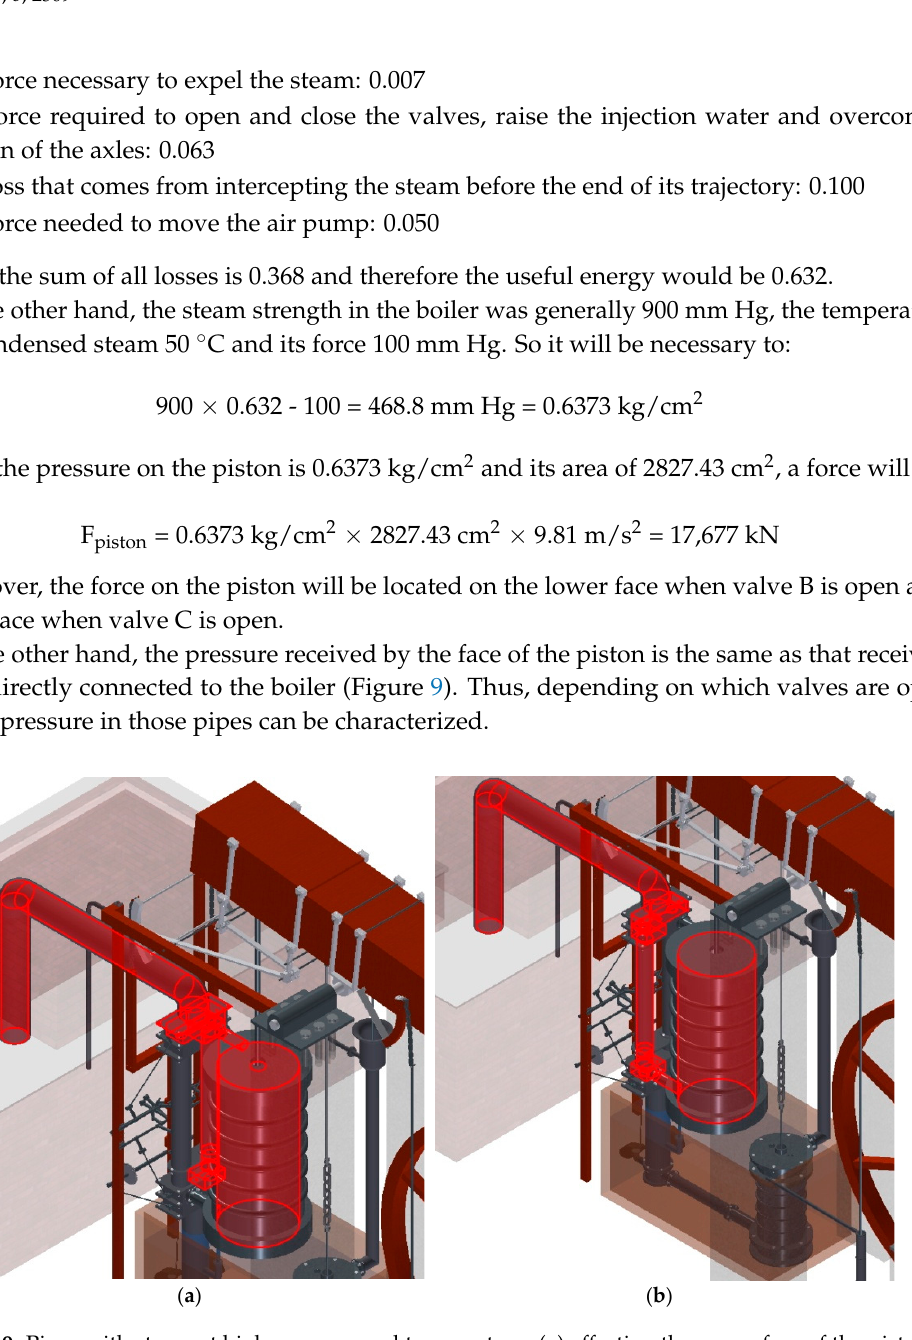
Figure 9. Pipes with steam at high pressure and temperature: ( a ) affecting the upper face of the piston and ( b ) affecting the lower face of the piston.